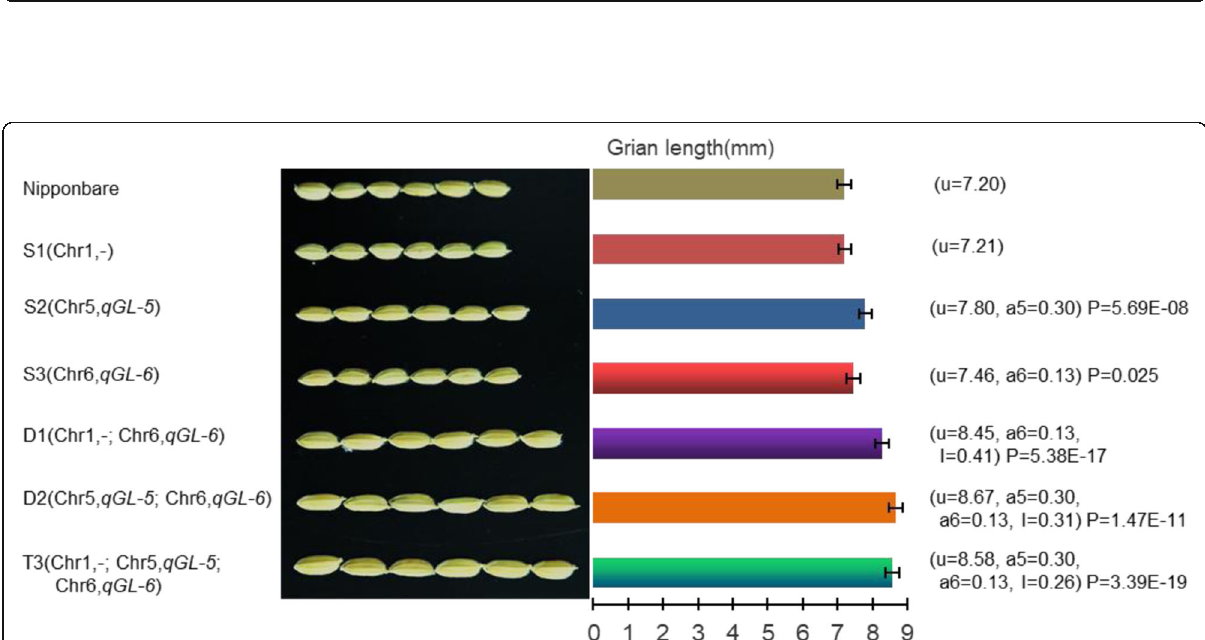
Fig. 5 Fine mapping of putative qGL-6 and sequence analysis of candidate genes. a qGL-6 was mapped to an interval of 1.26 Mb. b The grain length of the 241 recombinants and 10 Nipponbare. c The DNA sequence of OsARF19 in Z1392 compared with Nipponbare